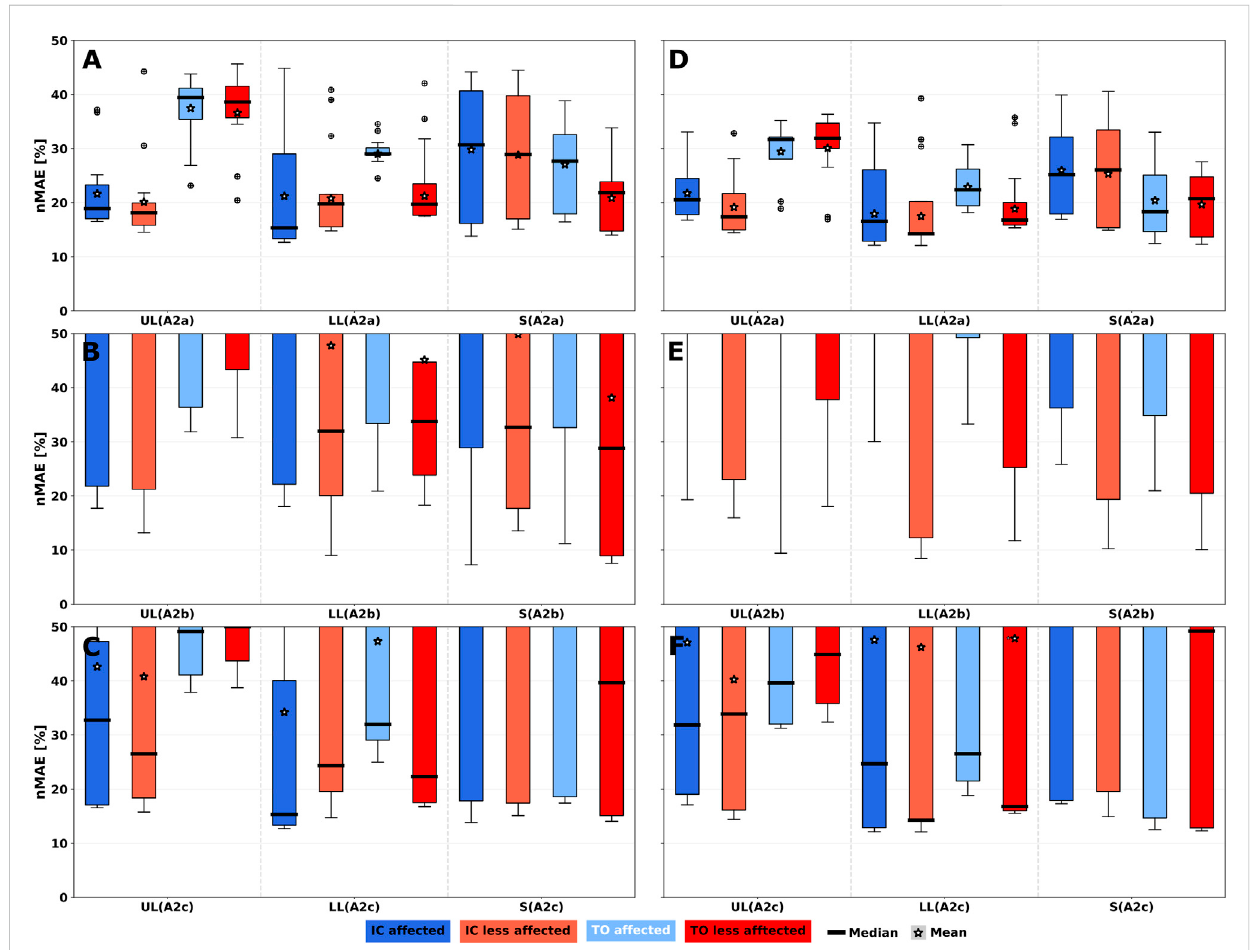
FIGURE 7 2-phase gait event nMAE of all simulated sensor positions summarised per body segment for Algo. A2 variants. nMAE axes were limited to highlight practically relevant sensor performances with nMAE below 50%. For full-range diagrams, please see Supplementary Figure S6. Gait events are Initial Contact (IC) and Toe off (TO). (A – C) PRE intervention. (D – F) POST intervention. (A,D) User-dependent and sensor position-dependent parameterisation (A2a). (B,E) User-independent parameterisation by averaging parameters across training set patients (A2b). (C,F) User-dependent and sensor position-independent parameterisation by averaging parameters across body segments (A2c). UL: Upper leg; LL: Lower leg; S: